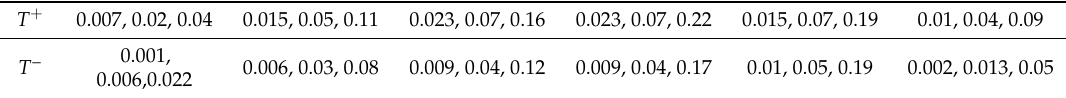
Table 12. First part of Fuzzy Positive Ideal Solution (FPIS) and Fuzzy Negative Ideal Solution (FNIS).